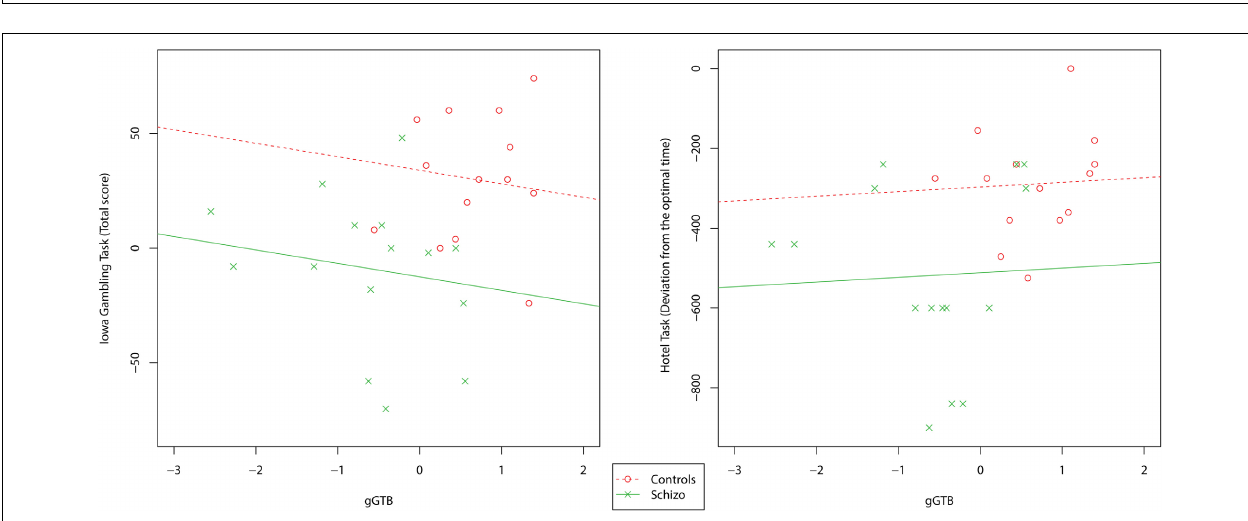
FIGURE 2 | Scatterplots relating g GTB to the multitasking and decision-making tests. Regression lines reflect the average within-group association of the two variables, as determined by ANCOVA, constrained to have the same slope across